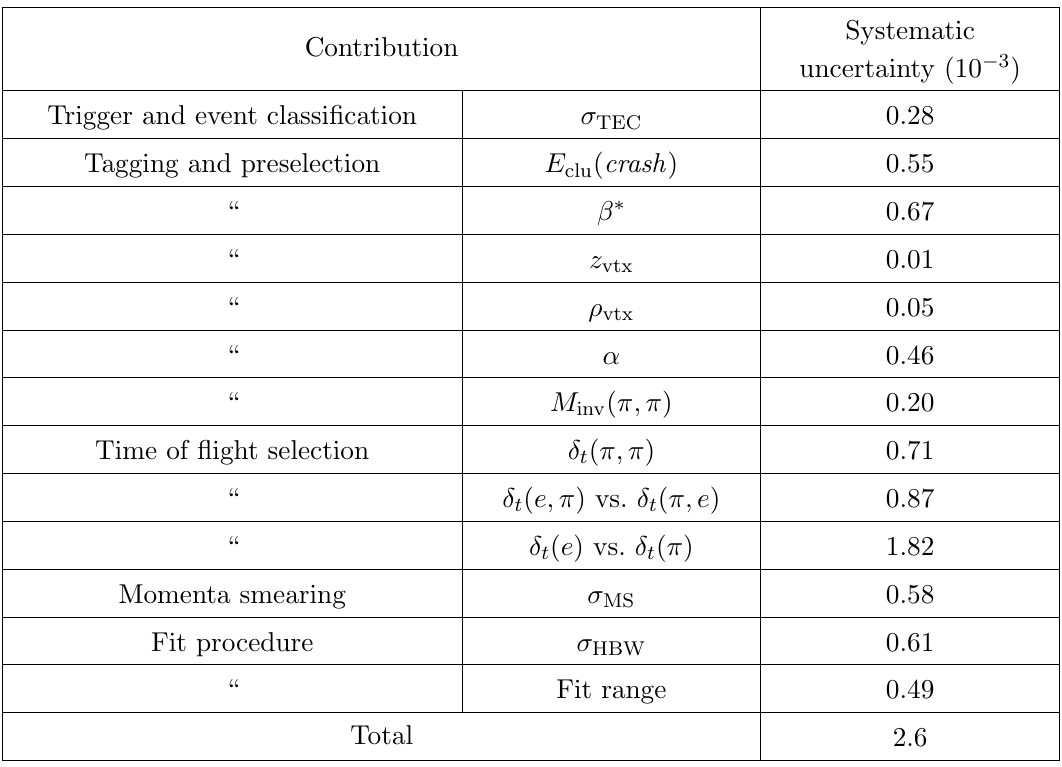
Table 2 . Summary of contributions to the systematic uncertainty on A S